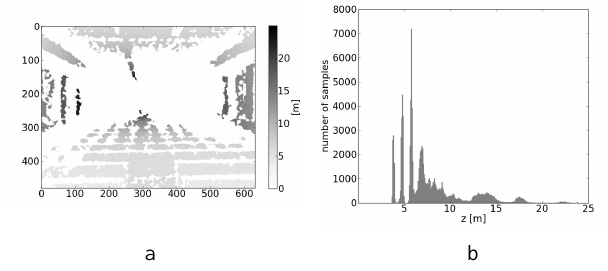
Figure 8. Mean depth: a) gray-coded image, b) histogram. As can be seen in Figure 9a, the standard deviation increases with depth, where most of the values are below and a maximum of 1.41 m is given.